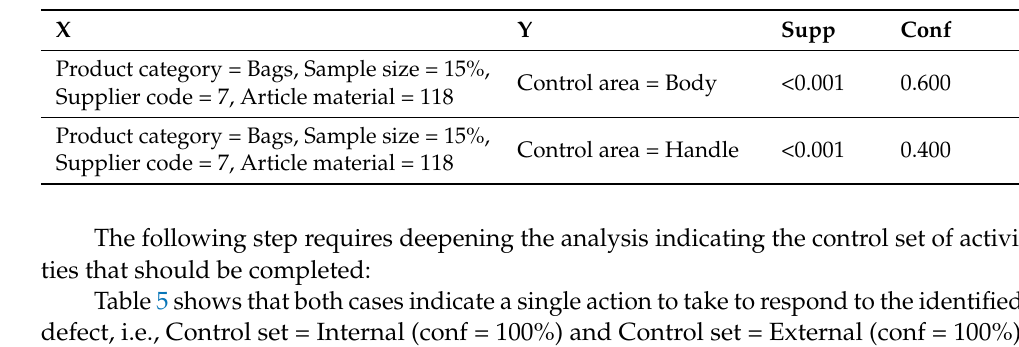
Table 4. Examples of the rules in the form of supplier code, sample size, product category, article material, and control area.